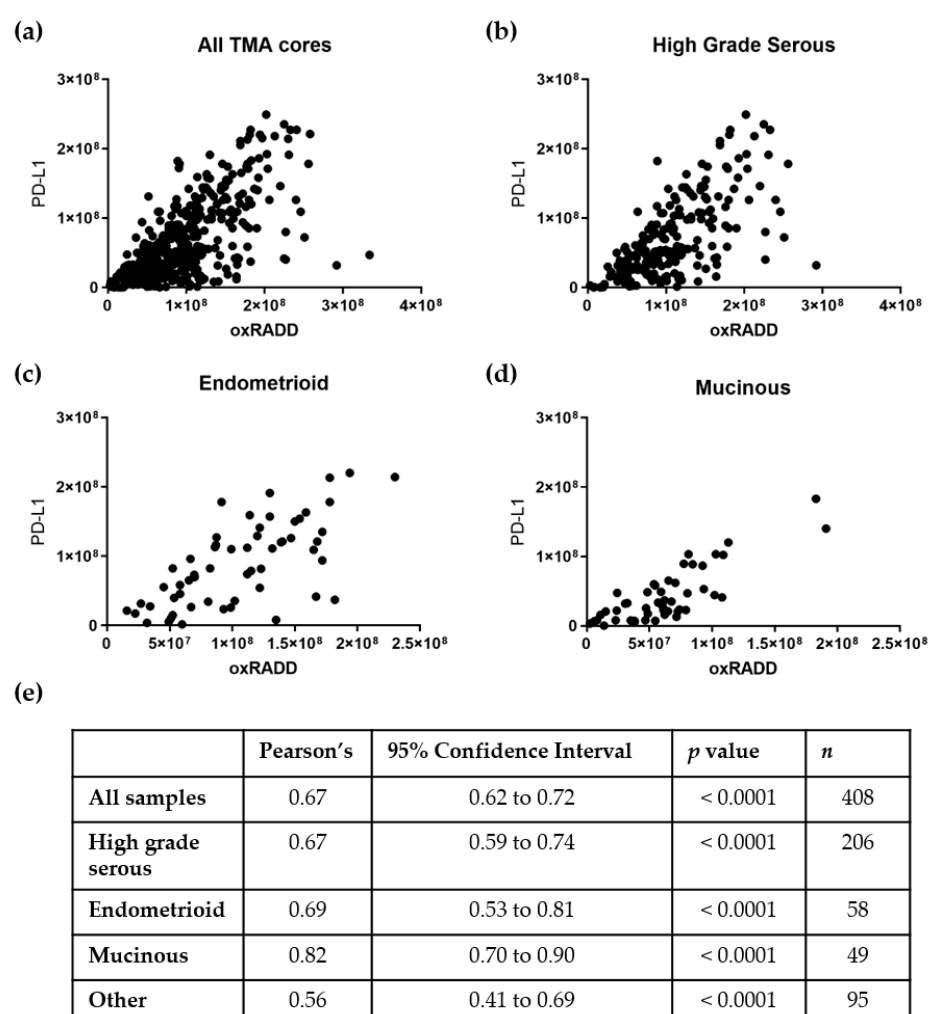
Figure 6. Pearson’s correlation of PD-L1 expression and oxidative DNA damage for all ovarian TMAs ( a ) and individual pathological subtypes ( b – d ). ( e ) Table of summary statistics for the correlation analysis.